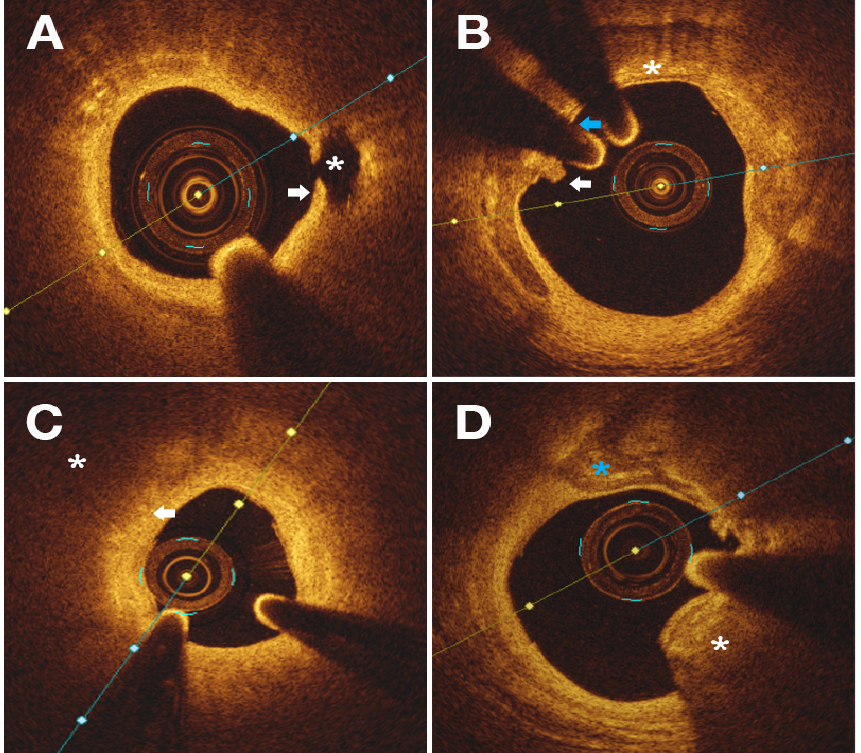
Figure 2. Representative OCT images of culprit lesions. ( A ) Plaque rupture with a disrupted fibrous cap (arrow) and a clear cavity (star). ( B ) Plaque erosion. White thrombus (white arrow) overlying a thin fibrous cap (blue arrow) and calcium sheets (star), with no evidence of rupture. ( C ) Significant stenosis within lipid-rich plaque (star), which exhibits signs of macrophage infiltration (arrow). ( D ) Calcified nodule (white star) with adjacent calcium sheets (blue star).